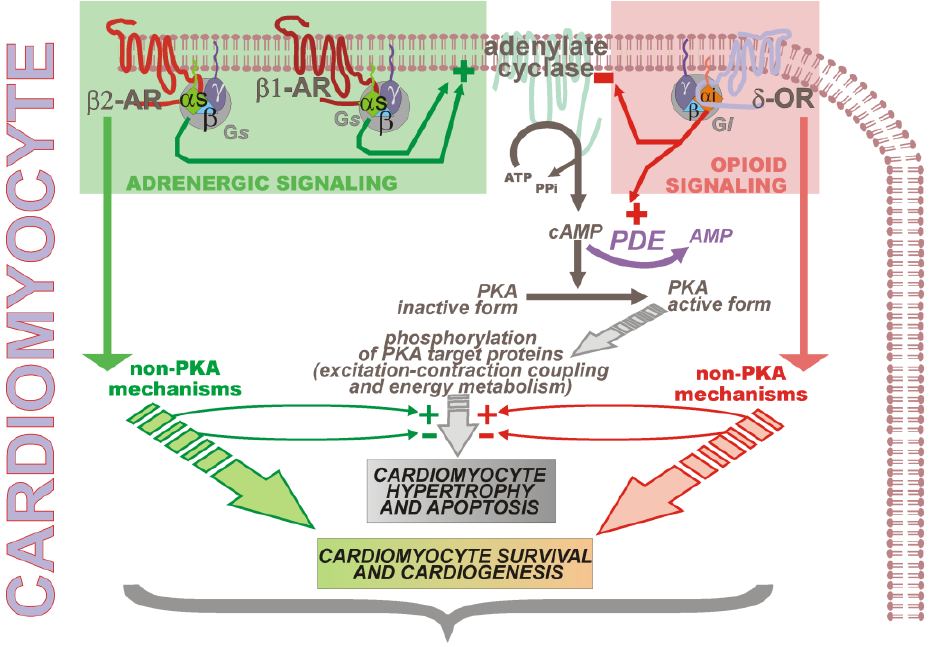
Figure 1. Cross-talk between β-adrenergic and δ-opioid signaling pathways in cardiomyocytes as an experimental basis for regulation of myocardial cell calcium and